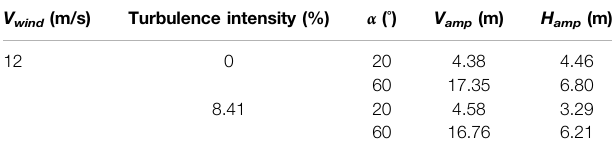
intensity. V wind (m/s) Turbulence intensity